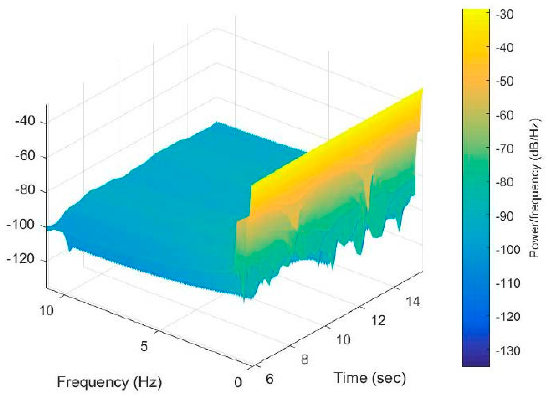
Figure 10. Waterfall spectrum.